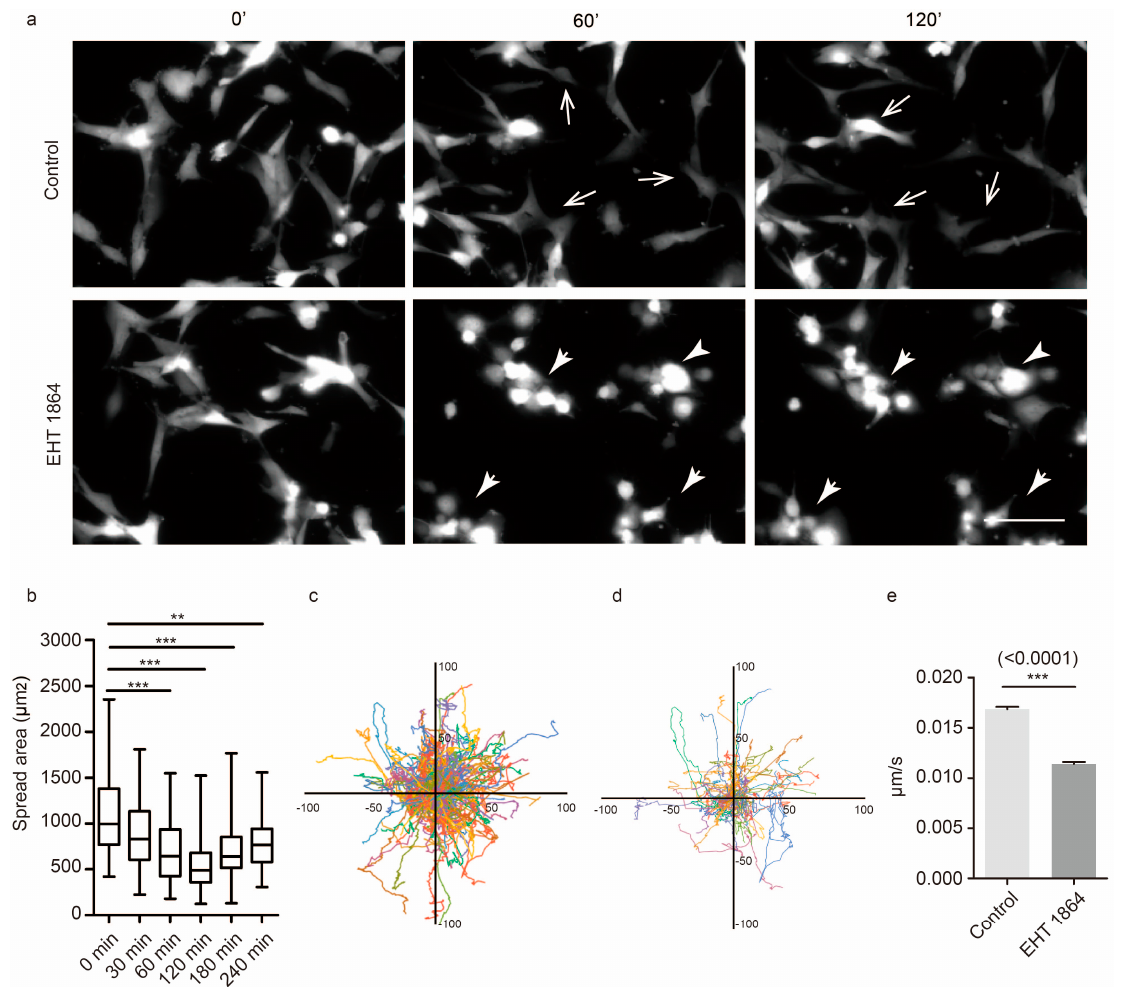
Figure 2. Rac1 activity affects random movement. ( a ) Time ‐ lapse images of U87 ‐ mCherry cells. After 4 h recording, cells were incubated with EHT 1864 and recorded for another 4 h. Open arrow indicates cells that rapidly move, and the solid arrow indicates cells that slowly move. ( b ) U87 ‐ mCherrycell spreading areas were quantified using the ImageJ program (NIH) after EHT 1864 added for 30, 60, 120, 180, and 240 min. ( c,d ) Cell trajectories of normal U87 cells ( c ) and EHT 1864 ‐ treated U87 cells ( d ) for 4 h; each color represents the trajectory of an individual cell, and the starting positions of each cell were registered to the center of the plot. ( e ) The mean velocity of U87 ‐ mCherry cells was recorded for 4 h and analyzed using the ImageJ program (NIH). Recordings of U87 ‐ mCherrycell movement are shown in Videos S1 and S2. Cell number: 277 cells in control group and 241 cells in EHT 1864 treated group. ***: p < 0.001, **: p < 0.01. Scale bar: 100 μ m.